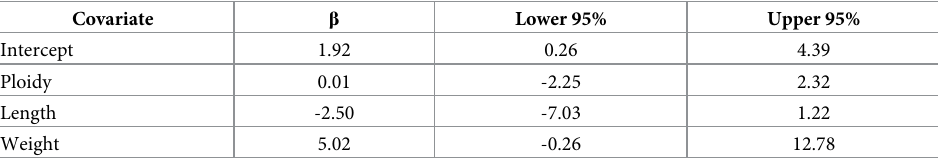
Table 3. Beta coefficient estimates and 95% confidence intervals for fixed effects for a logistic regression model of grass carp Ctenopharyngodon idella spawning migration behavior on the Osage River above Truman Reservoir, Missouri,